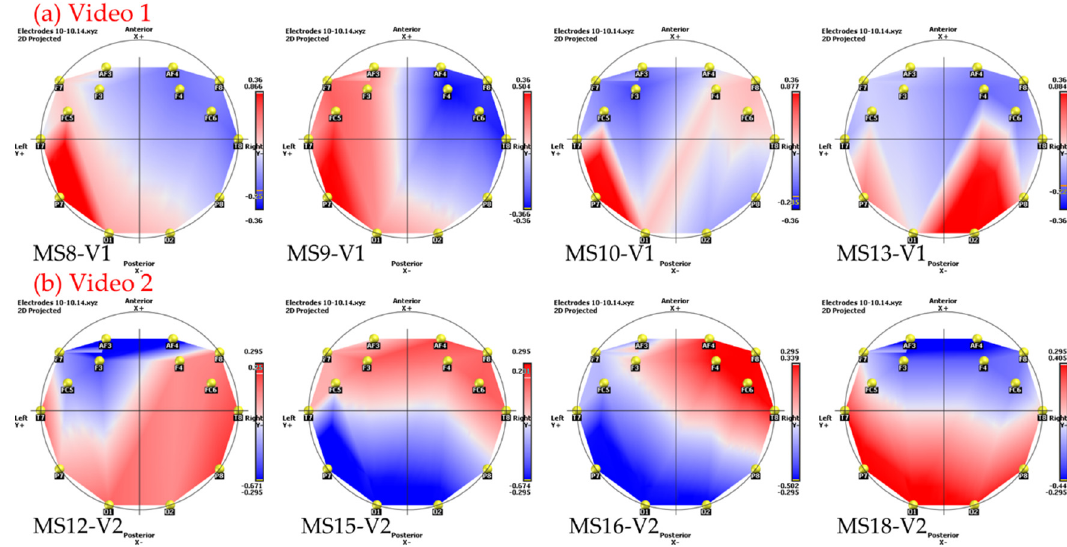
Figure 1. EEG microstate maps by the signals captured with Emotiv EPOC+ device: ( a ) The first panel includes the most representative maps in video 1 according to the number of repetitions and the time present: MS8-V1, MS9-V1, MS10-V1, MS13-V1; ( b ) The second panel includes the most representative maps in video 2 according to the number of repetitions and the time present: MS12-V2, MS15-V2, MS16-V2,